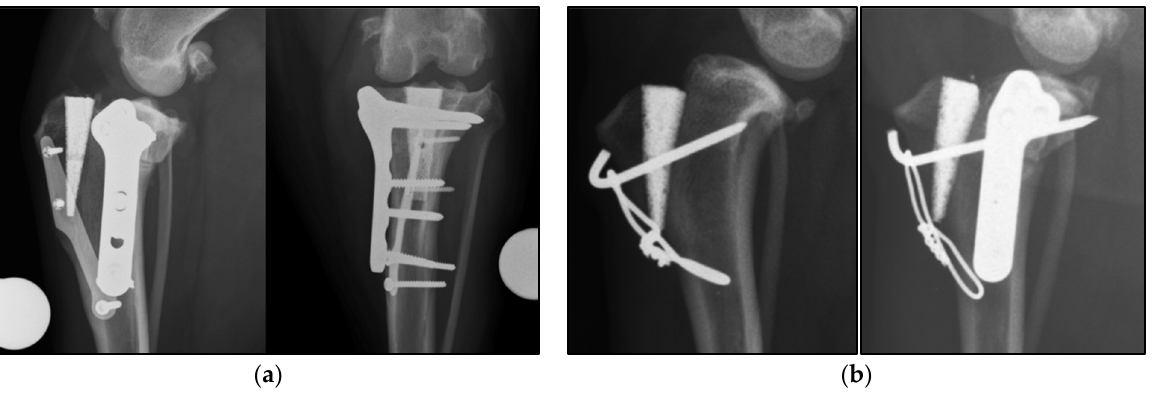
Figure 2. ( a ) 8 weeks postoperative mediolateral and craniocaudal radiographs of Case 1. The proximal tibial osteotomy was performed caudal to the TTAT implants. No interaction between the TPLO plate and the index implants occurred. ( b ) Preoperative and 8 weeks postoperative mediolateral radiographs of Case 5. The tension band was removed before performing the TPLO to avoid interaction of the pin with the osteotomy and replaced at the end of the procedure.